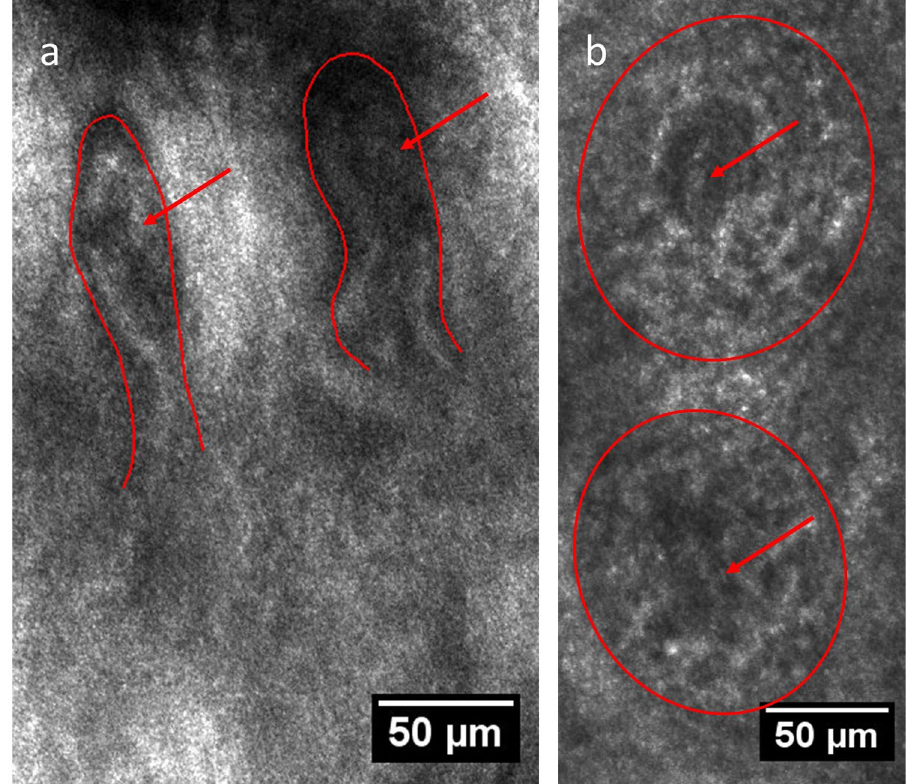
Figure 1. Capillaries of human skin in vivo in ( a ) fingernail bed, 150 μ m depth, ( b ) inner forearm, 60 μ m depth as seen via LSM (reflection mode); the red lines correspond to papillae borders, and the red arrows indicate the position of capillary loops inside the papillae. The scanning wavelength was set to 785